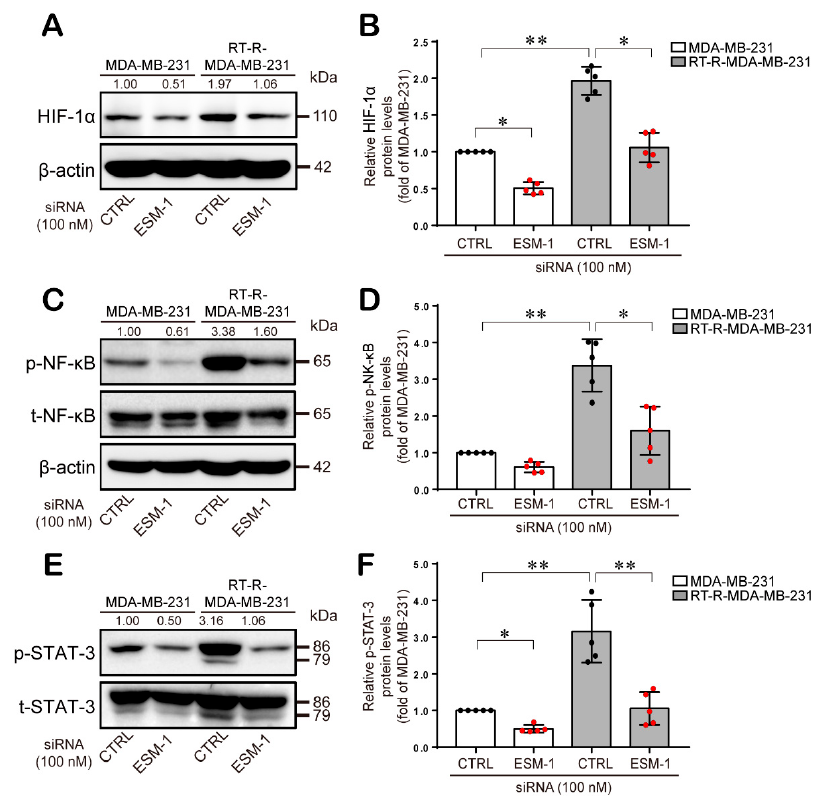
Figure 5. HIF-1 α induction and NF- κ B and STAT-3 phosphorylation are increased in RT-R-MDA-MB-231 cells compared to MDA-MB-231 cells and are downregulated by ESM-1 knockdown. Cell lysates were obtained from the CTRL- or ESM-1 siRNA-transfected cells, and western blotting was performed to detect HIF-1 α ( A ), phospho-NF- κ B/NF- κ B ( C ), and phospho-STAT-3/STAT-3 expression ( E ). Band